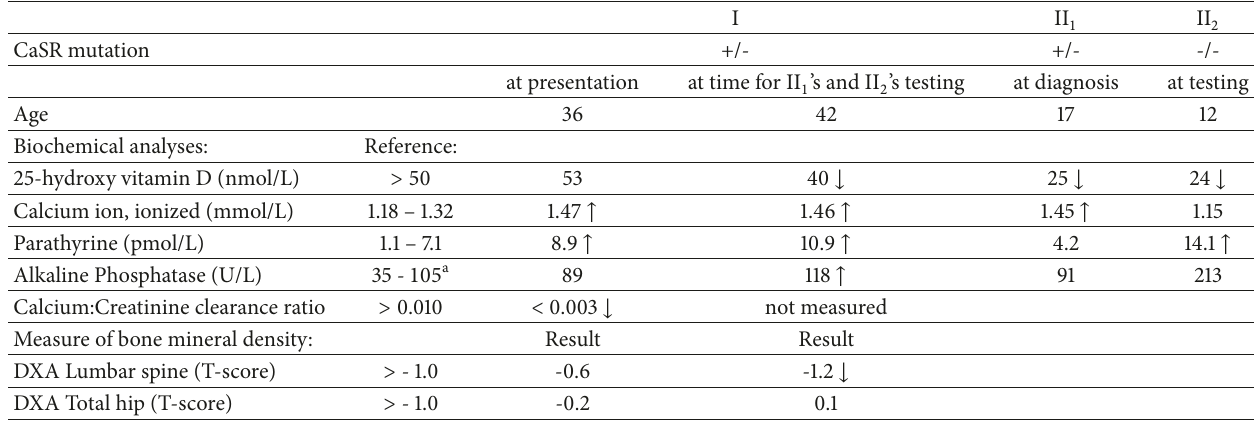
Table 1: Results from biochemical analysis and measures of bone mineral